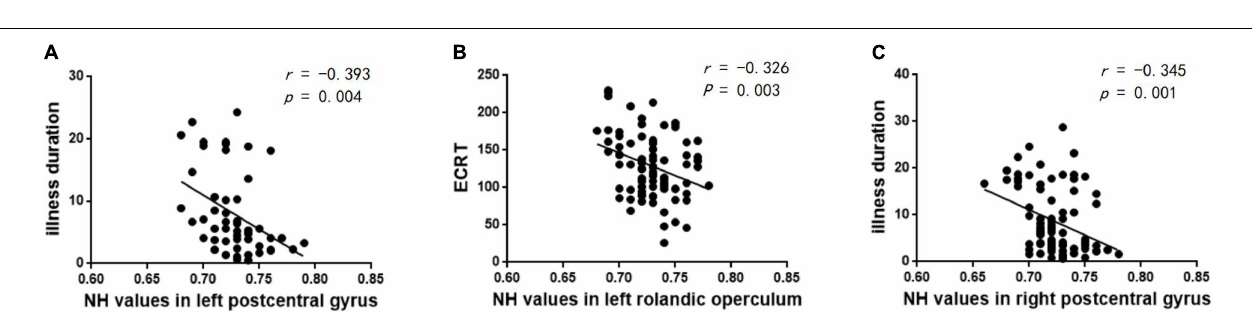
FIGURE 5 | Correlations between abnormal NH and clinical variables. (A) Negative correlation between the NH values in the left postcentral gyrus and illness duration in the lTLE group. (B) Negative correlation between the NH values in the left Rolandic operculum and ECRT in the rTLE group. (C) Negative correlation between the NH values in the right postcentral gyrus and illness duration in the rTLE